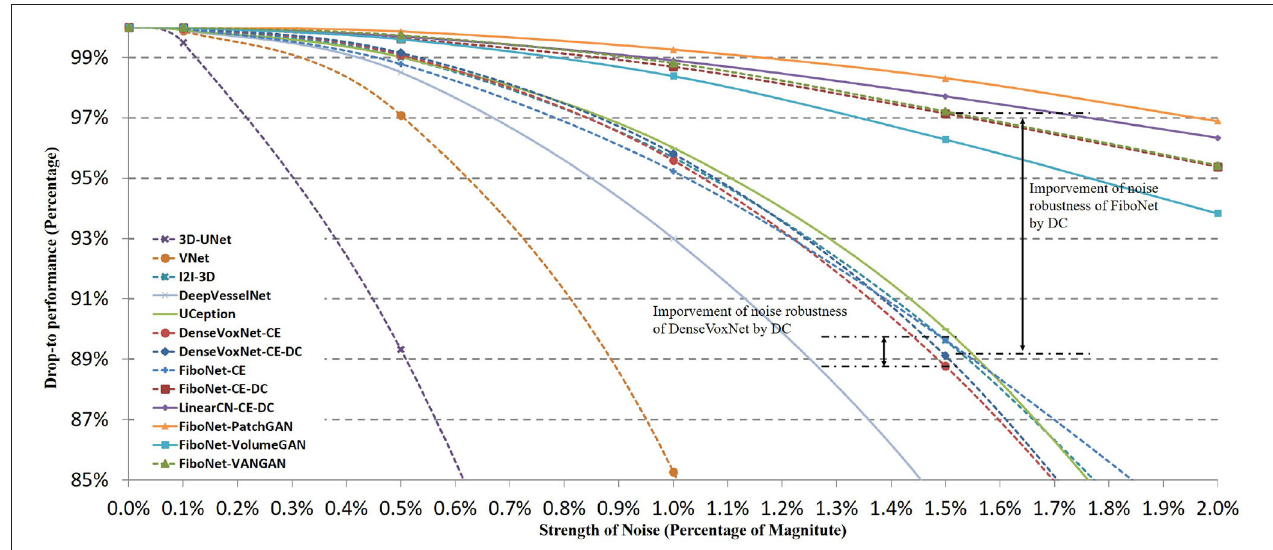
FIGURE 9 | Influences of different magnitudes of Gaussian noise on the segmentation accuracy of different methods. Horizontal axis represents the strength of noise added. Vertical axis represents drop-to performance of a certain method compared with the situation when no Gaussian noise is added.